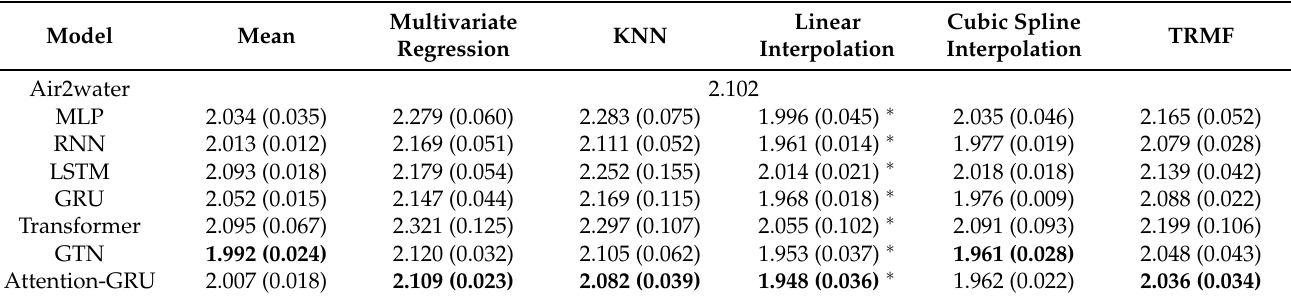
Table 6. The values of the evaluation index RMSE. The values in the table represent the mean (standard deviation) of the ten experimental results. The best prediction model results for each missing value imputation method are shown in bold. “ ∗ ” represents the best result for the prediction model.